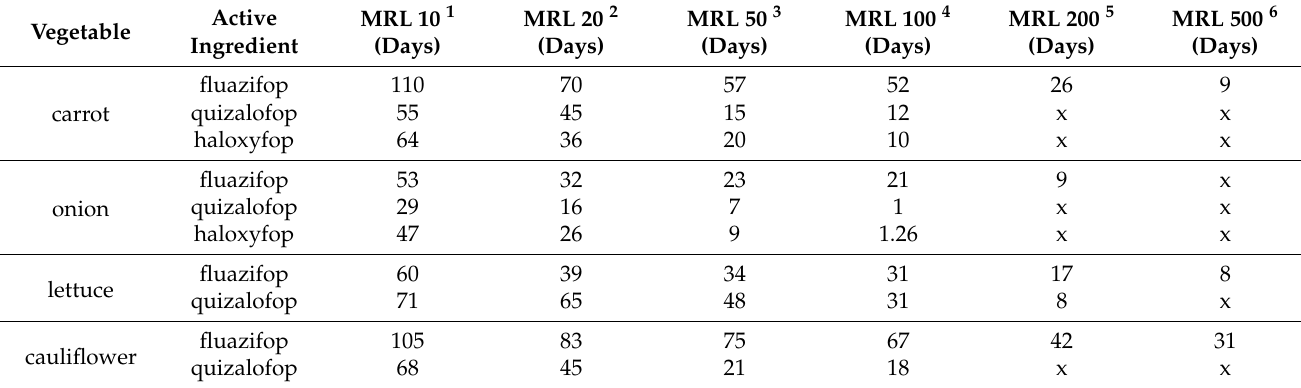
Table 8. Hypothetical pre-harvest interval for different MRL.